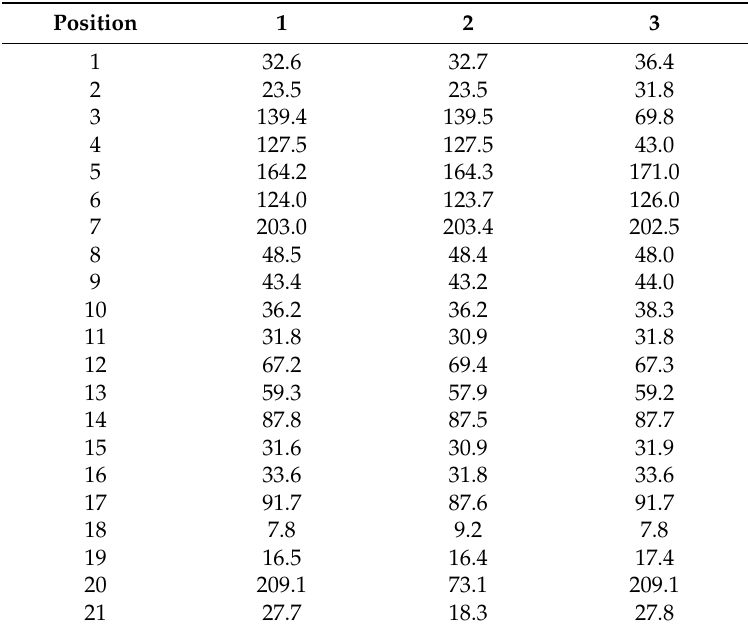
Table 1. 13 C-NMR spectral data of compounds 1 – 3 (125 MHz, C 5 D 5 N, δ in ppm).